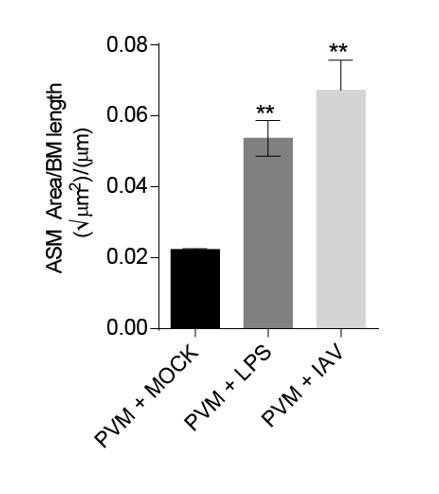
DOI:
http://dx.doi.org/10.7554/eLife.21199.018